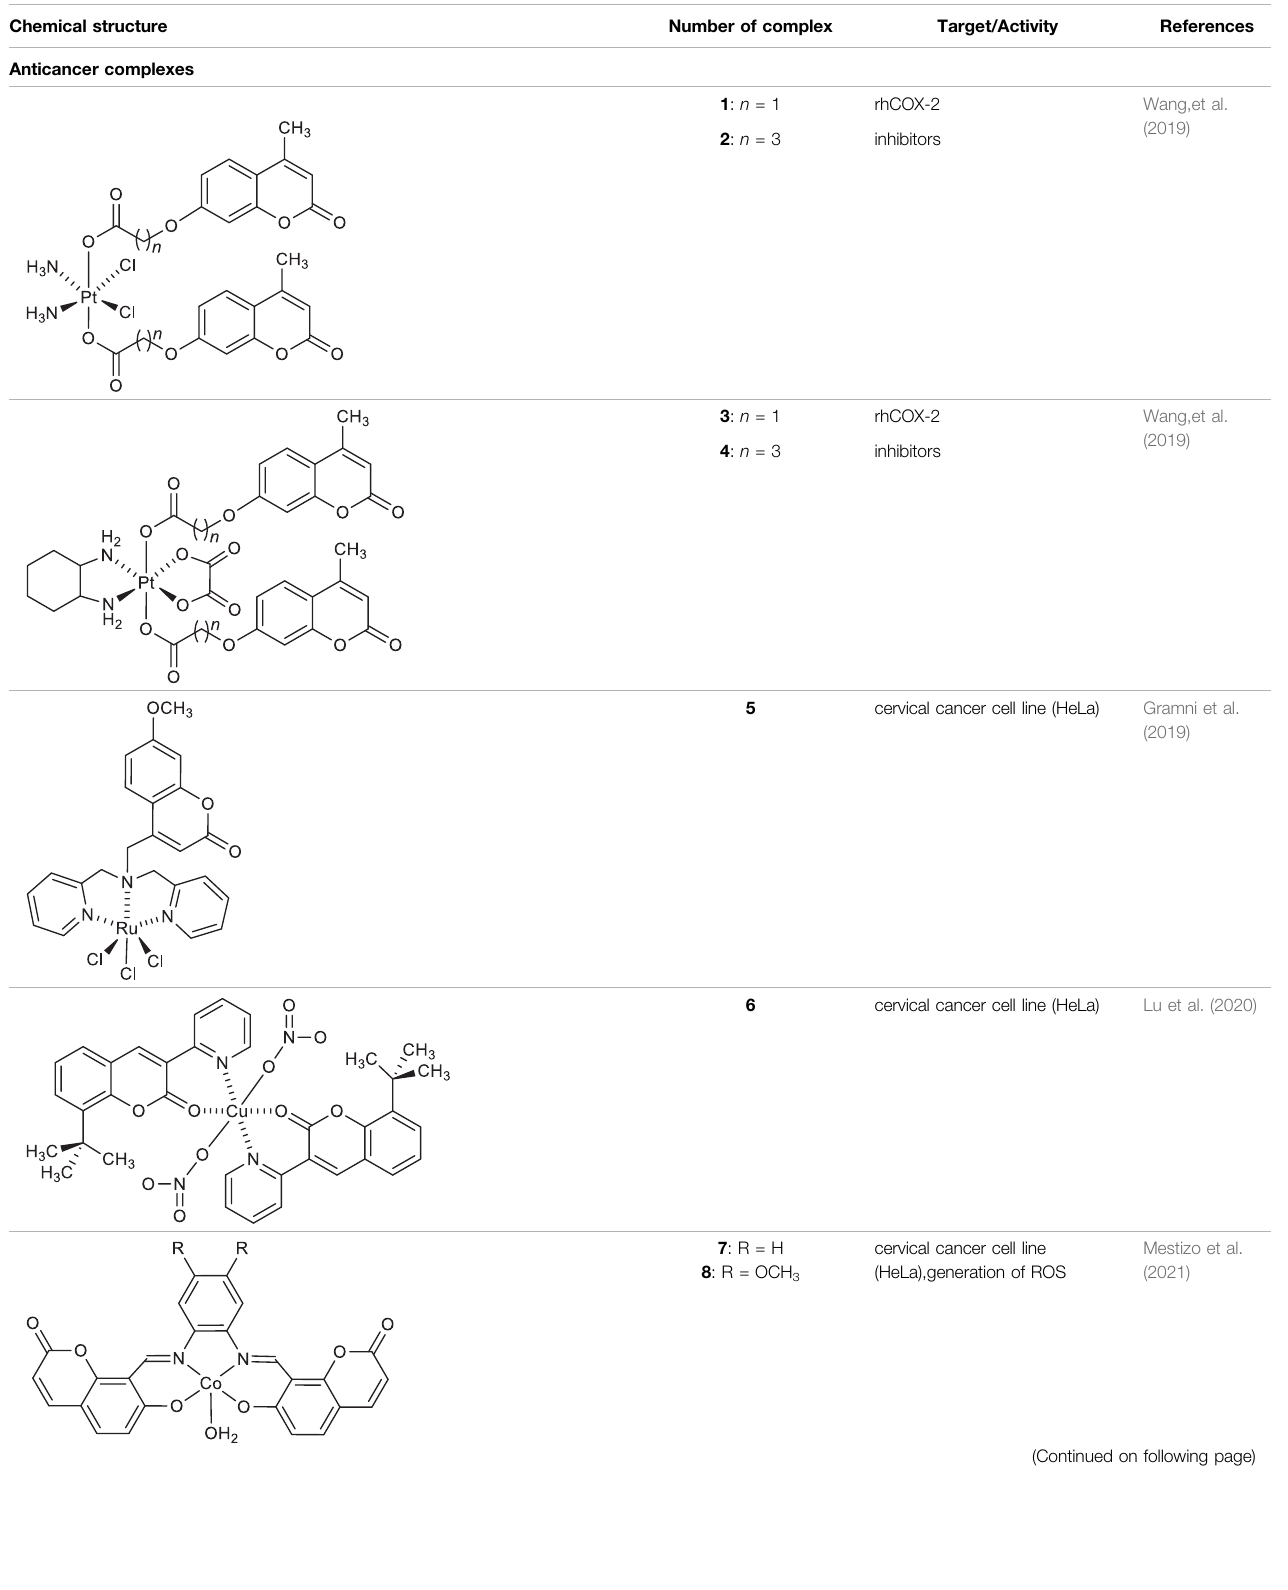
TABLE 1 | Coumarin-based metal complexes with diverse biological